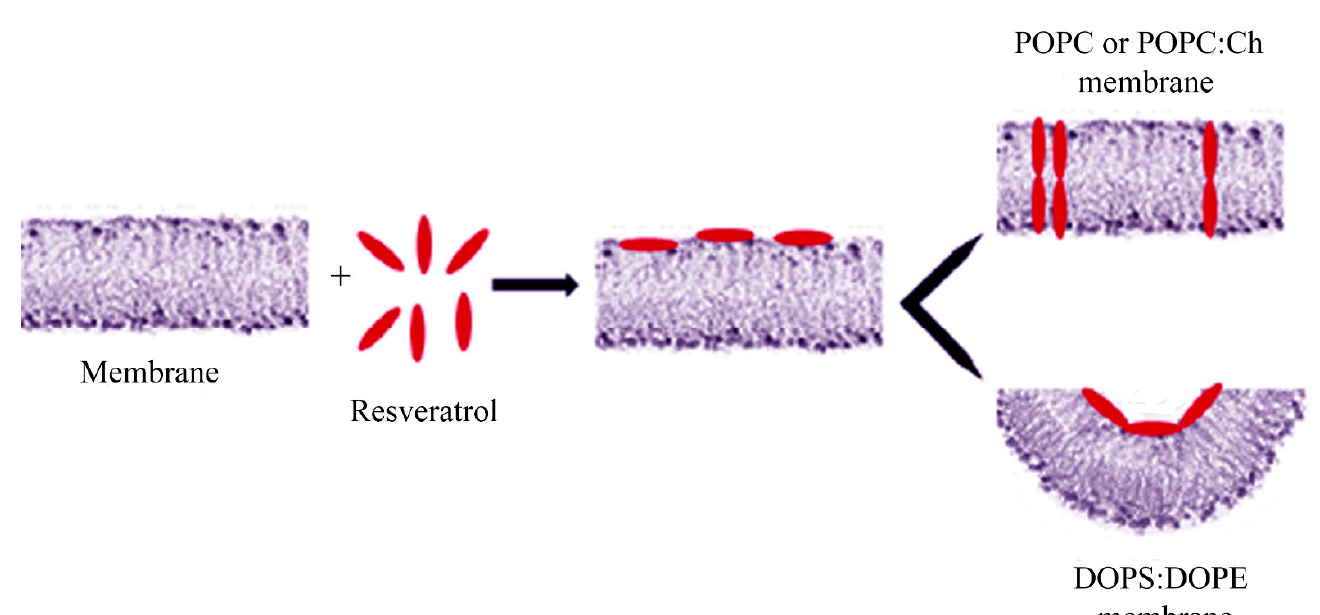
Figure 6. Schematic model of the resveratrol interaction with PLM at different lipid composition. Resveratrol adsorbs onto the membrane surface, regardless to the PLM composition. In POPC or POPC:Ch PLMs (top), resveratrol inserts and assembles into membrane forming conductive units, once an appropriate resveratrol/lipid ratio has been reached. In DOPE:DOPS PLMs (bottom), resveratrol inducing negative curvature of membrane is unable to insert into it.